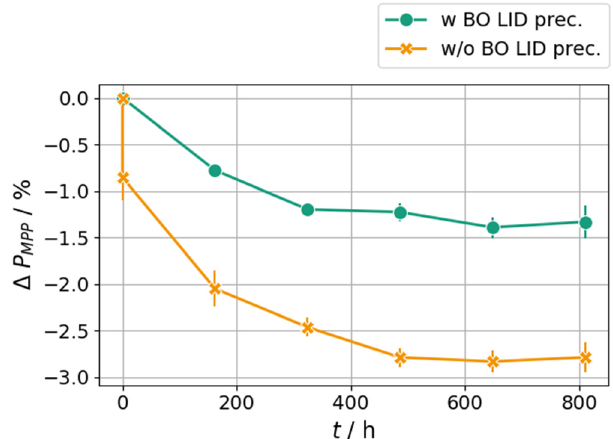
Fig. 6. Relative changes of the STC performance parameters of modules M04 and M05 during LETID testing at 75 ° C and MPP mode after BO LID stabilization. Average values over two modules; Error bars: min / max values of the two modules.